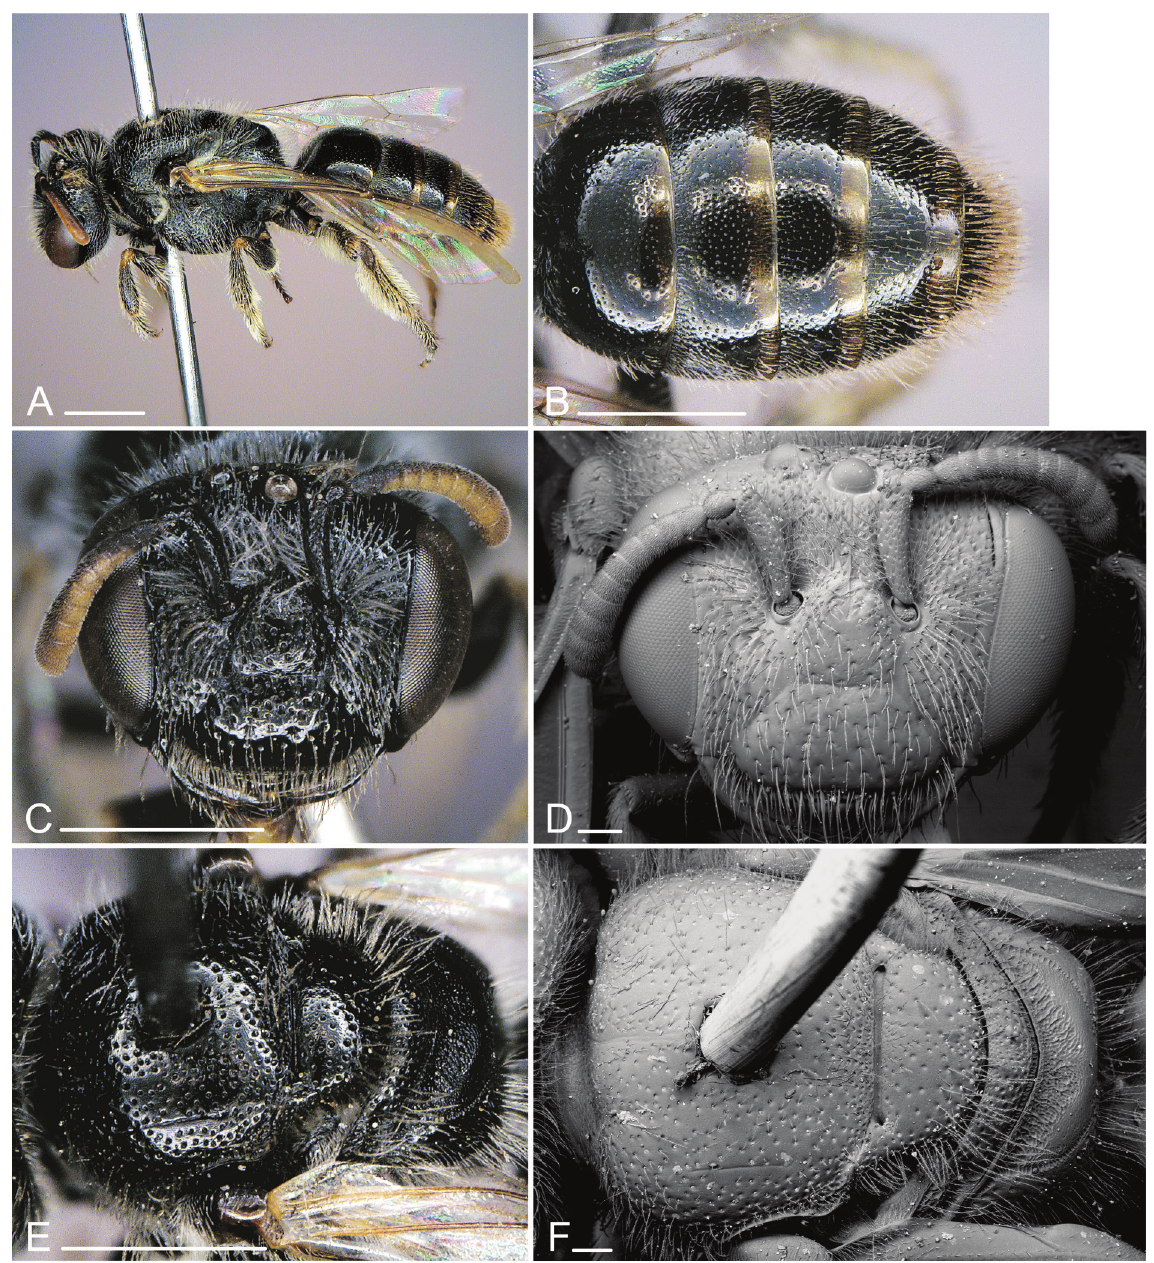
Fig. 1. Scrapter acanthophorus Davies, 2005, ♀. A . Lateral view. B . Metasoma (dorsal view). C . Head. D . Head (SEM). E . Thorax (dorsal view). F . Thorax (dorsal view, SEM). Scale bars: photos: 1 mm, SEM: 0.1